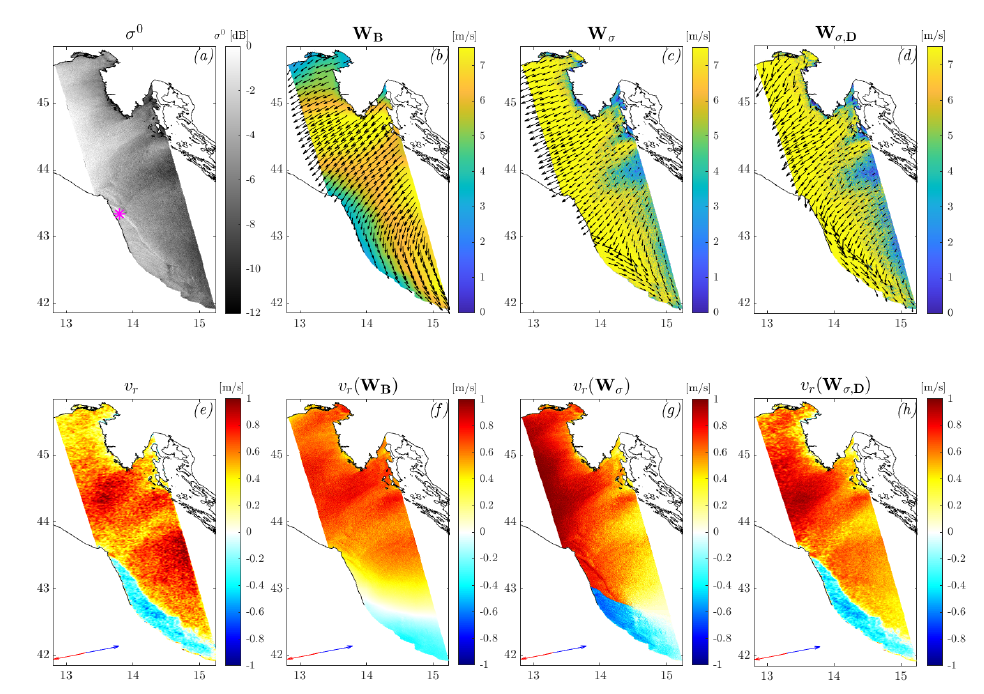
Figure 4. Results related to the ENVISAT/ASAR ascendent acquisition of 18 November 2005. The image is divided into panels labelled as described in Figure 3. The magenta asterisk in panel ( a ) indicates the location in which the components of the cost function of Figure 5 are computed. The red and blue arrows on the bottom left of the panels ( e , f ) denote the radial component of the sea surface velocity, respectively toward (red) and away from (blue) the sensor.